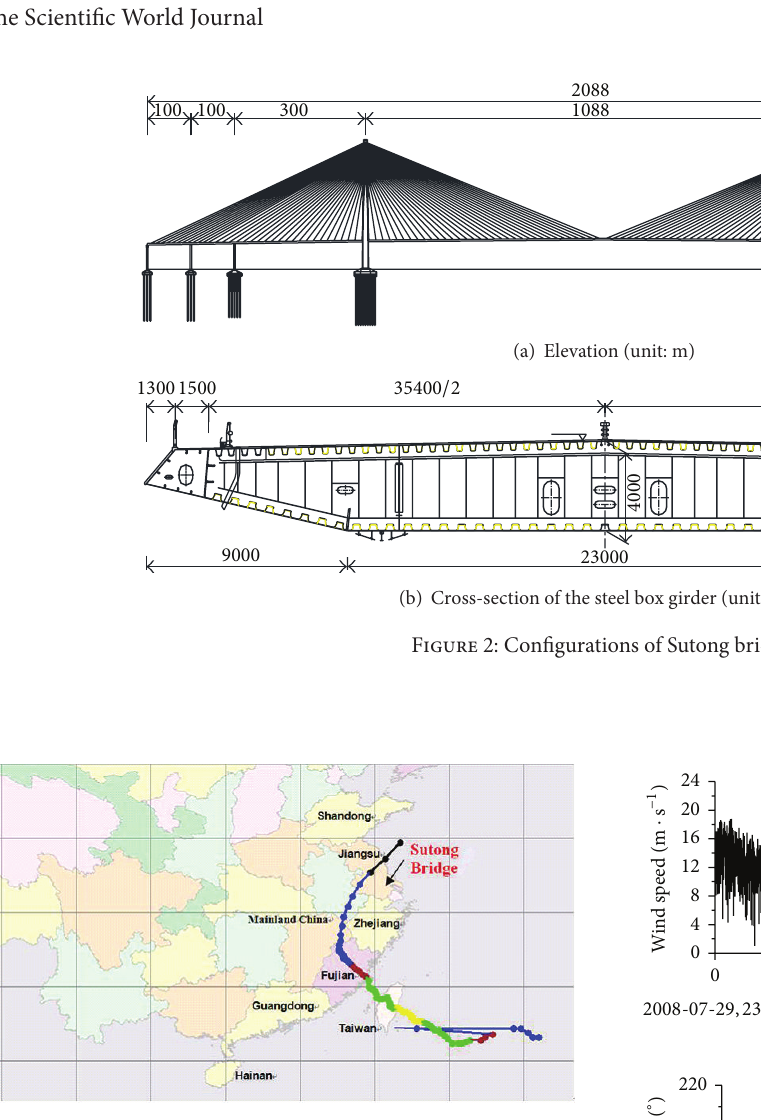
Figure 3: Moving track of Typhoon Fung-Wong.